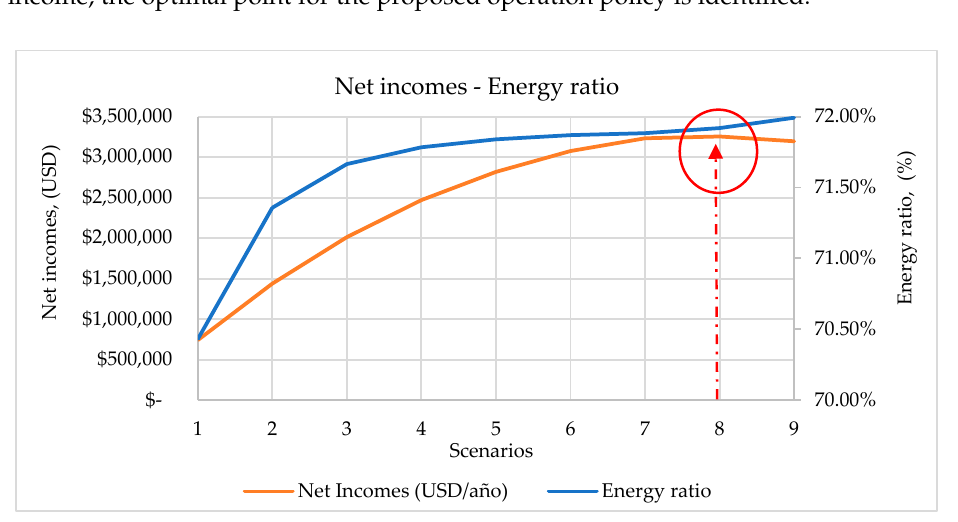
Figure 12 . Comparison between net revenue and G/B energy ratio . Own source with analysis of Figure 12. Comparison between net revenue and G/B energy ratio. Own source with analysis results. of